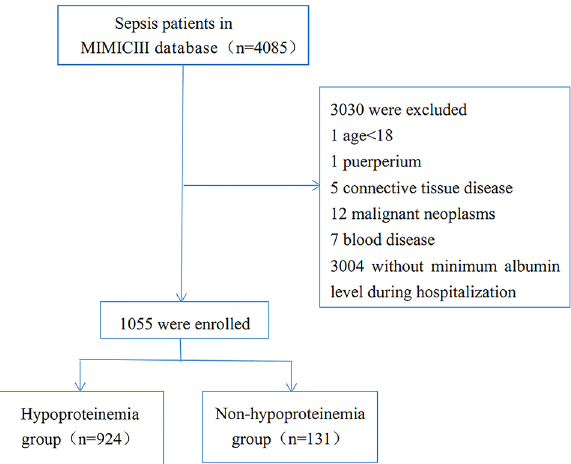
Figure 1. Flow chart.